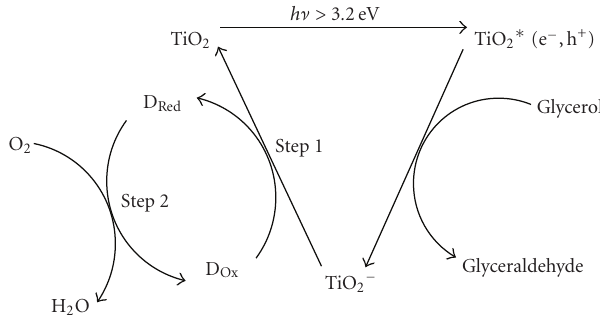
Figure 1: Schematic illustration of the key processes involved in the UV activation and subsequent response towards oxygen of a TO 2 /redox dye, D OX /glycerol/HEC oxygen indicator, such as that used in this work, where D OX =